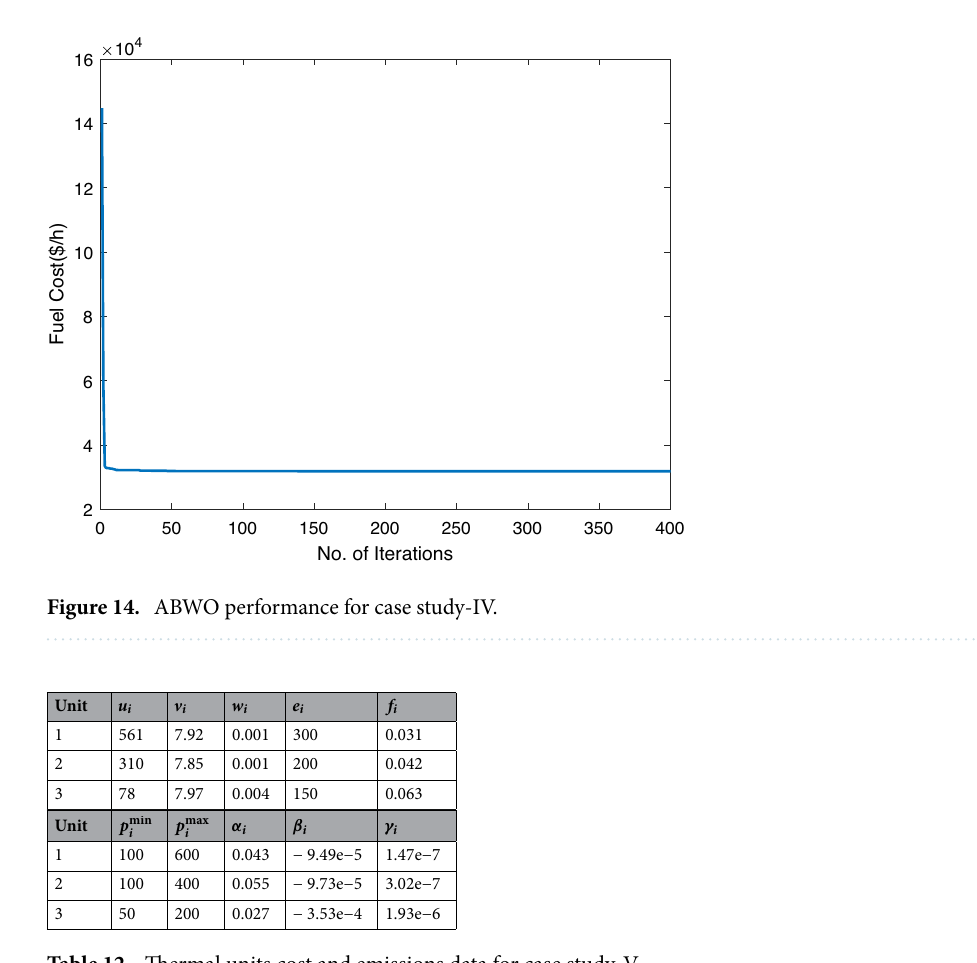
Table 12. Thermal units cost and emissions data for case study-V.